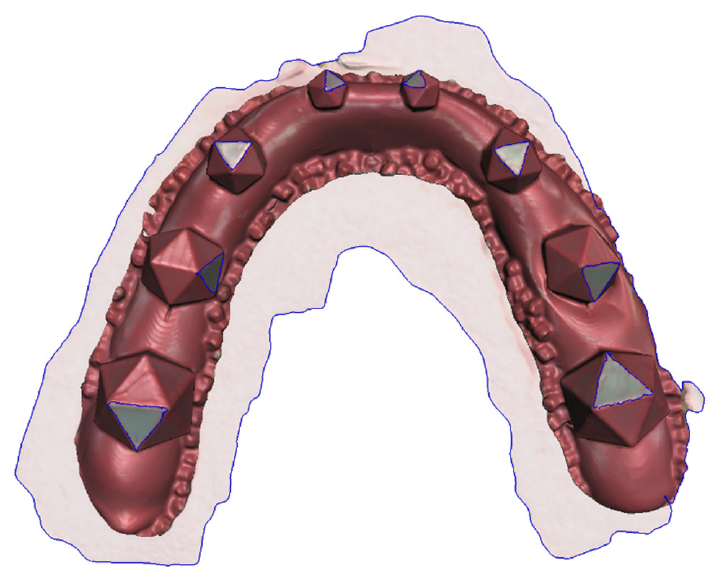
Figure 4. Example of a scanned splint after successful segmentation.